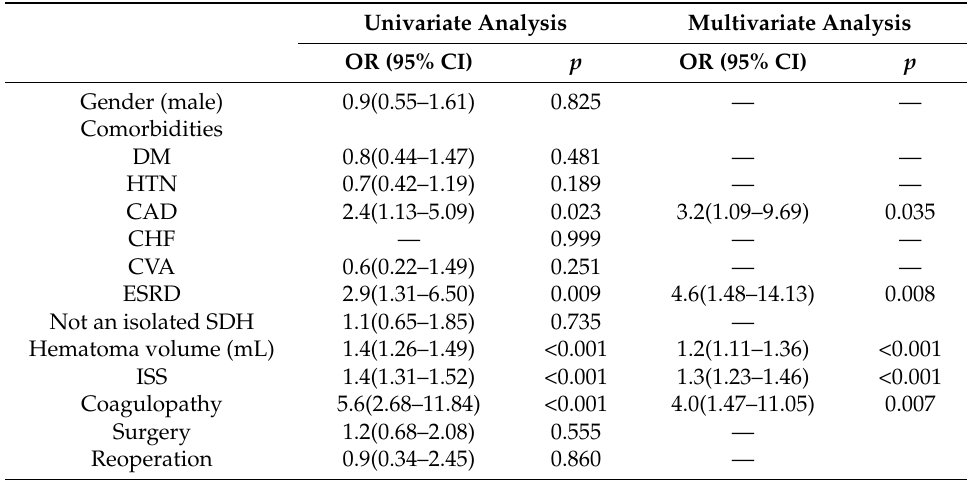
Table 2. Risk factors influencing mortality in adult patients who sustained a subdural hemorrhage in a fall, analyzed using univariate and multivariate logistic